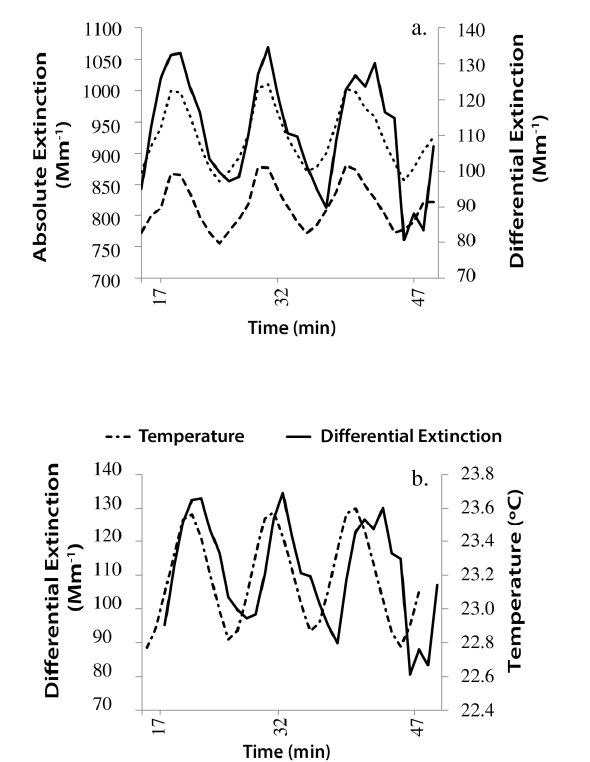
Fig. 4. (a) Online and offline absolute extinction signals and differ- ential extinction as a function of time measured during an afternoon where we noticed significant temperature fluctuations (1min aver- aging time). (b) Differential extinction and corresponding tempera- ture fluctuations during that afternoon (1min averaging